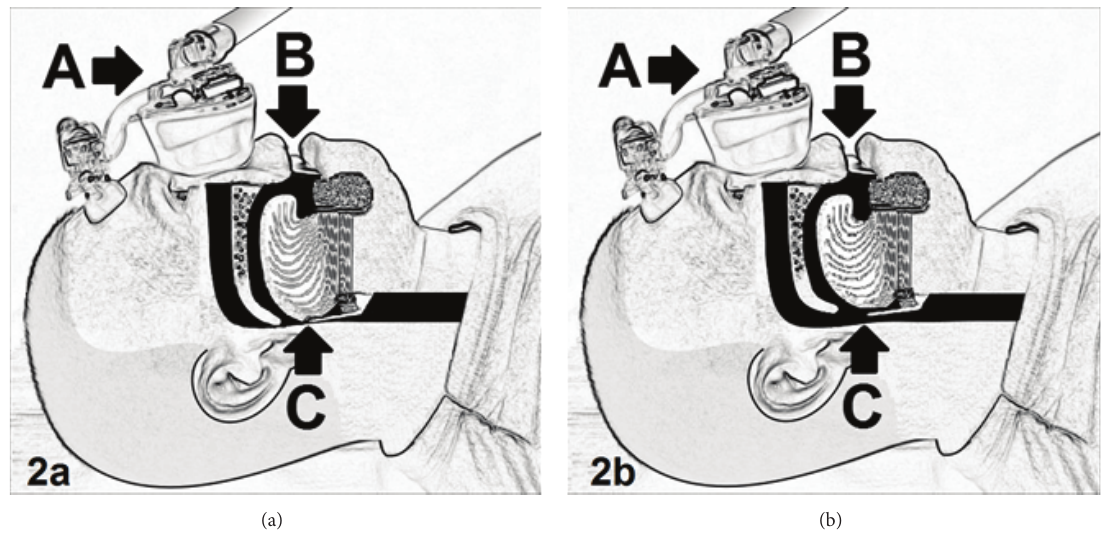
Figure 2: Fixed pressure delivered with a CPAP device (applied via a nasal soft-gel triangle mask) with the patient performing the Five- Minute CPAP Test using supine awake snoring. (a) demonstrates that the patient is able to snore at lower pressures with closure of the upper airway. (b) demonstrates a higher pressure at which the patient can no longer snore (Quiet Pressure) with an open airway. Labels: A = CPAP via a soft-gel nasal triangle mask, B = standard tongue depressor between teeth, and C = upper airway at the level of the soft palate, base of tongue, and